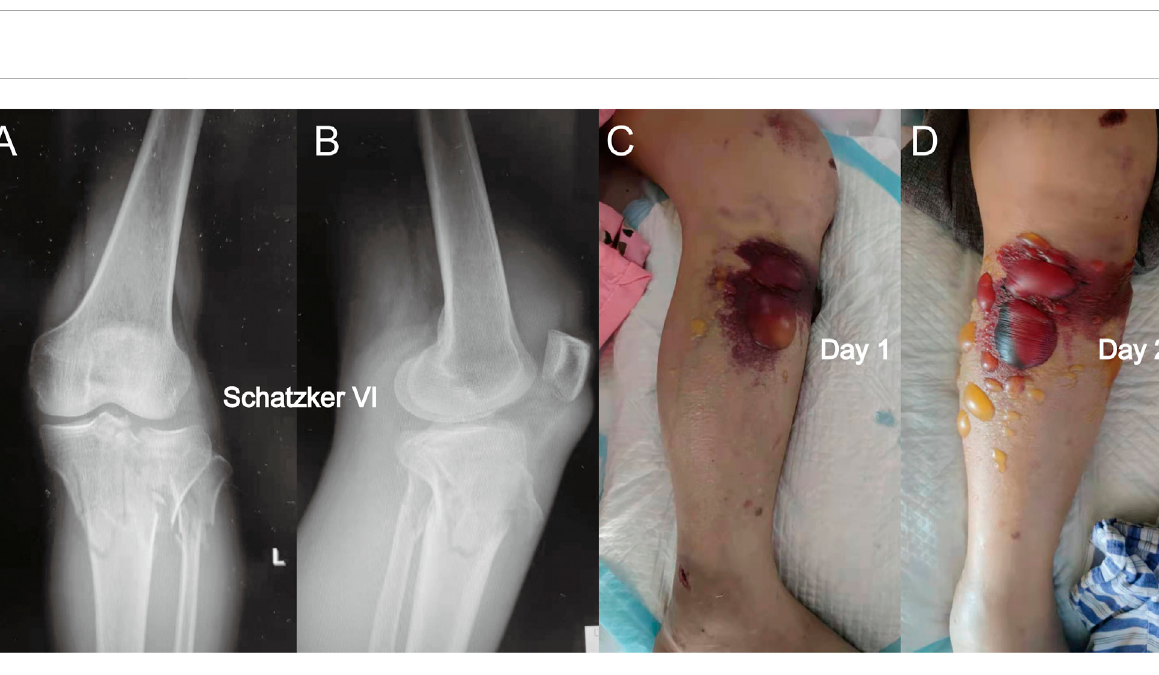
FIGURE 2 (A) Anterior-posterior X-rays of another Schatzker VI tibial plateau fracture. (B) Lateral view of this fracture. (C) Fracture appearance with a blood- fi lled blister. The blood- fi lled blister was larger than the serous blister observed in Figure 1. (D) Blister became larger after 1 day, and a